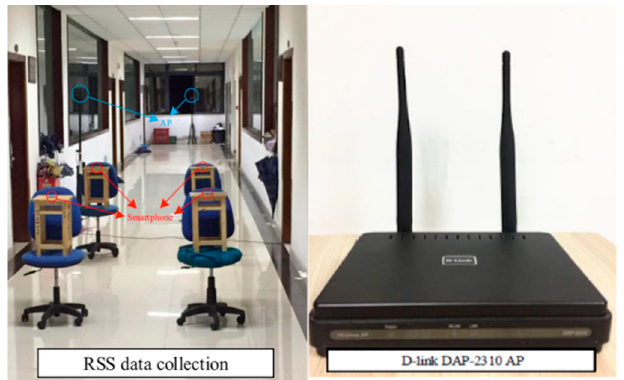
Figure 3. RSSI sampling.